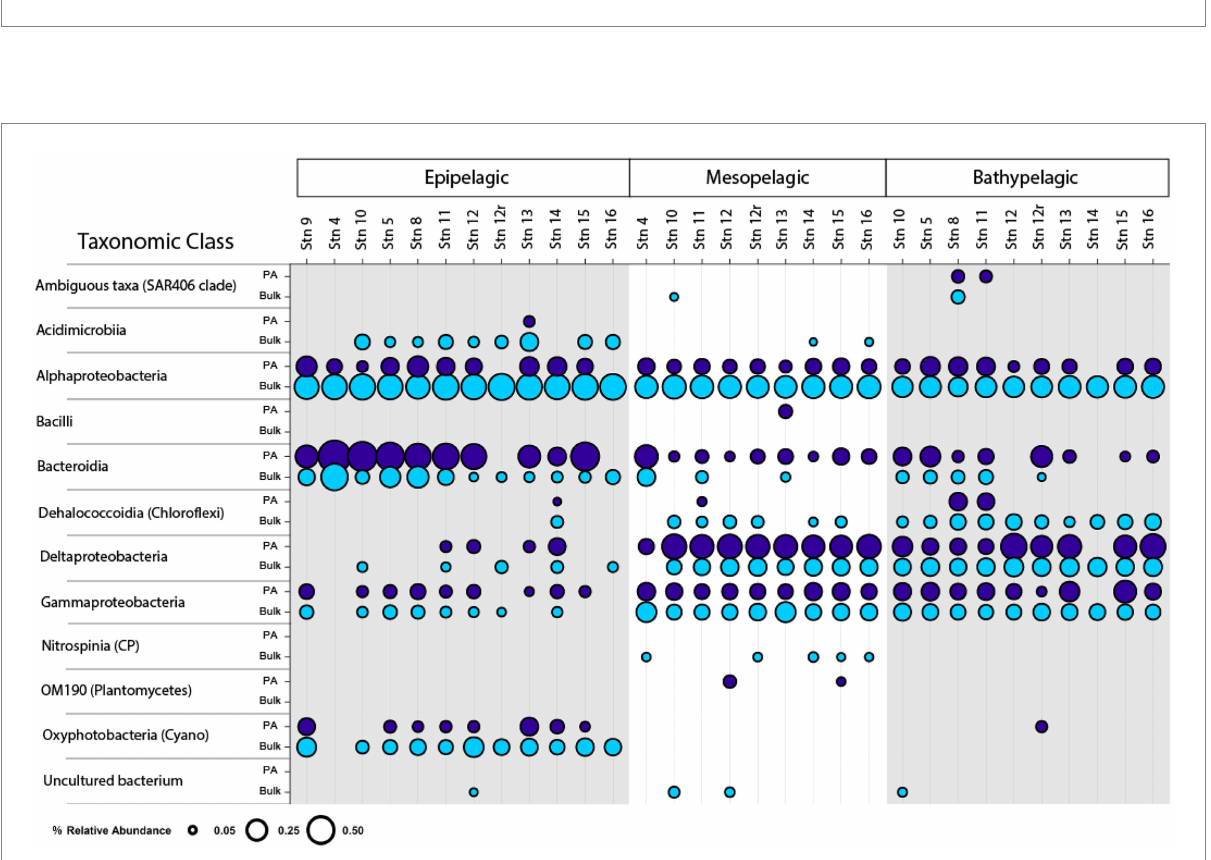
FIGURE 4 Fraction of bulk water polysaccharide hydrolase activities that is attributable to the PA fraction at each station and depth, calculated by comparing the maximum rate of the bulk water and the PA samples. Pul, pullulan; Lam, laminarin; Xyl, xylan; Fuc, fucoidan; Ara, arabinogalactan; Chn, chondroitin sulfate.